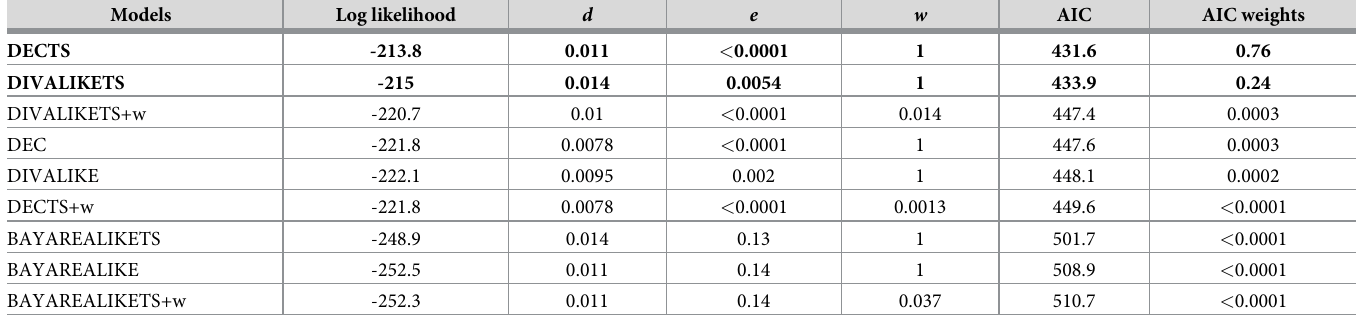
Table 1. Model comparisons on the ancestral range reconstruction of Bothrops forest clade performed with the phylogeny generated in this work. d , e and w are free parameters in models where d is the rate of range expansion (i.e. dispersal), e is the rate of range contraction (i.e. extinction), and w is a dispersal multiplier parameter. As the time stratified matrix (TS models) were generated with arbitrary numbers, the “+ w ” models leave the w parameter free and the matrix itself is raised to the w parameter to seek the best dispersal multiplier values. Best models (DECTS and DIVALIKETS) are